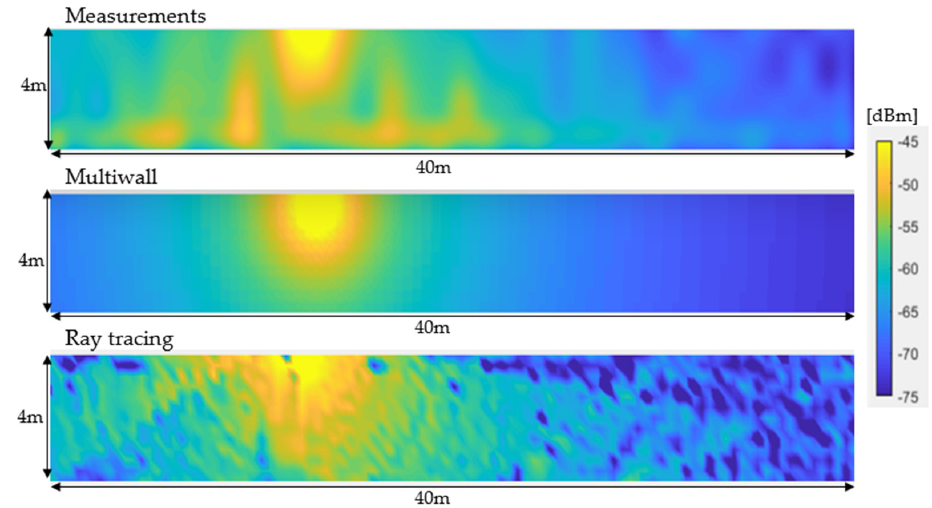
Figure 6. RSSI distribution datasets for one of the given (T1) transmitter. Reference datasets prepared by measurements, multiwall simulation method, and ray tracing simulation method.